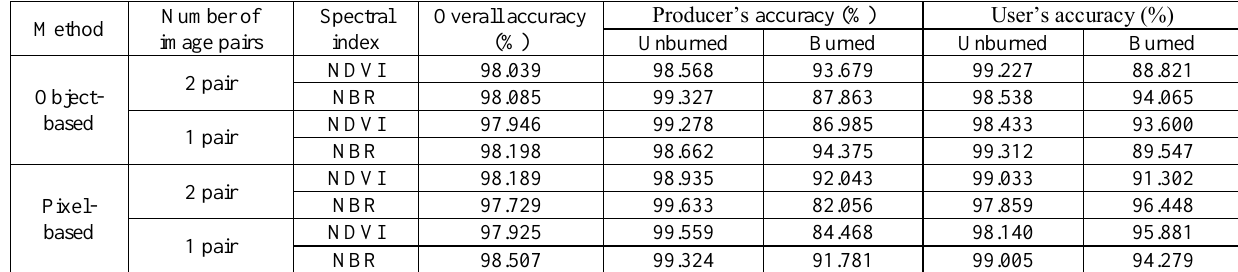
Table 4. Accuracy assessment (Overall accuracy, producer’s accuracy, user’s accuracy)